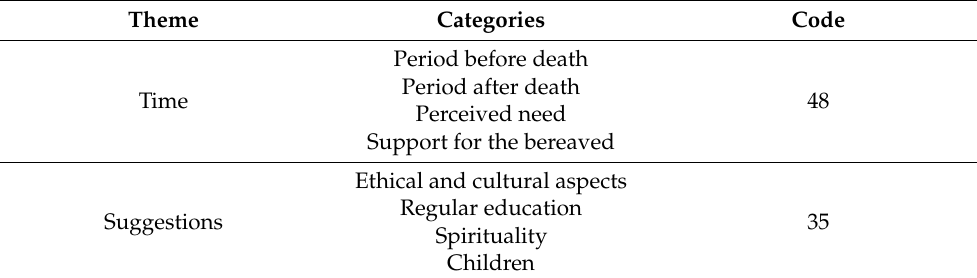
Table 5. Thematic analysis of open-ended